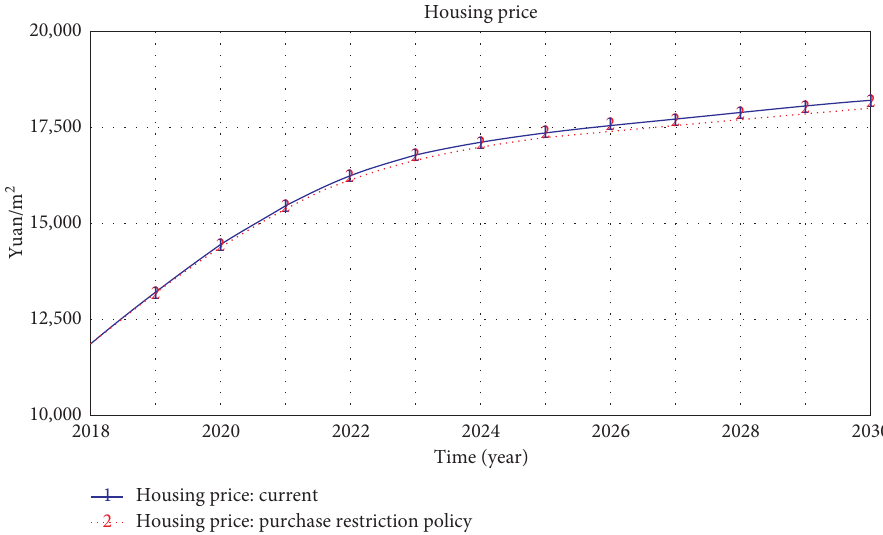
Figure 15: Influence of the regulation of purchase restriction policy on housing prices. Table 14: Comparison table of housing prices under the control of purchase restriction